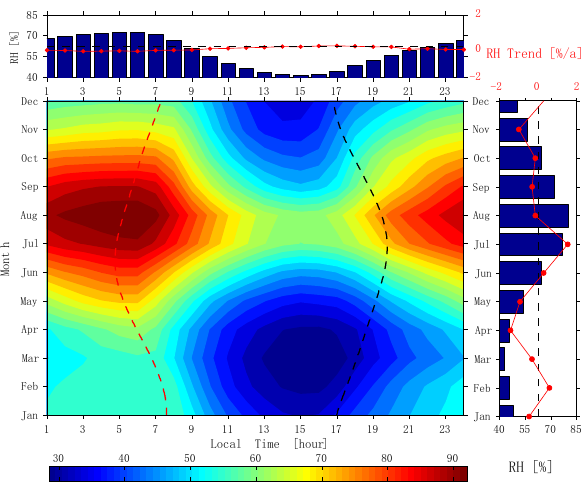
Fig. 4. RH distribution in relation to Month and Local Time (filled color). The blue bars at the top (on the right) denote mean visibility over the entire period 1999 to 2007 for each hour (month). The red curves denote visibility trend in BCIA from 1999 to 2007. Red dash line represents sunrise time and black dash line represents sunset